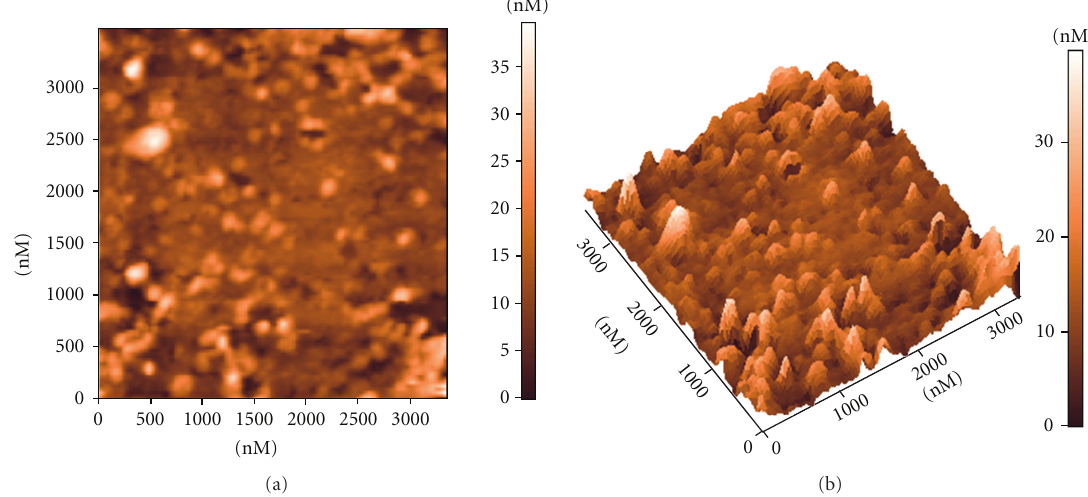
Figure 6: AFM images of the selenium nanoparticles formed by the reaction of 1 . 0 × 10 − 3 moldm − 3 sodium selenosulphate with 2 . 0 × 10 − 2 mol dm − 3 acetic acid, in the presence of 0.01 % PVA, (a) 2D image and (b) 3D